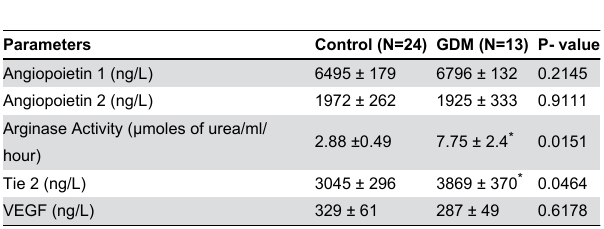
Table 2. Cord blood serum levels of different angiogenic factors and arginase activity.